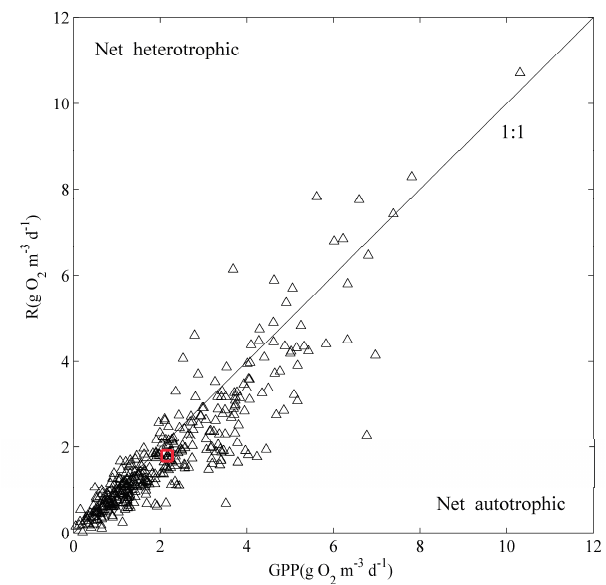
Figure 5. The relationship between gross primary production (GPP) and ecosystem respiration (R). Days that fall above the 1:1 line are net heterotrophic and days that fall below the 1:1 line are net autotrophic. The red circular symbol shows the mean value.